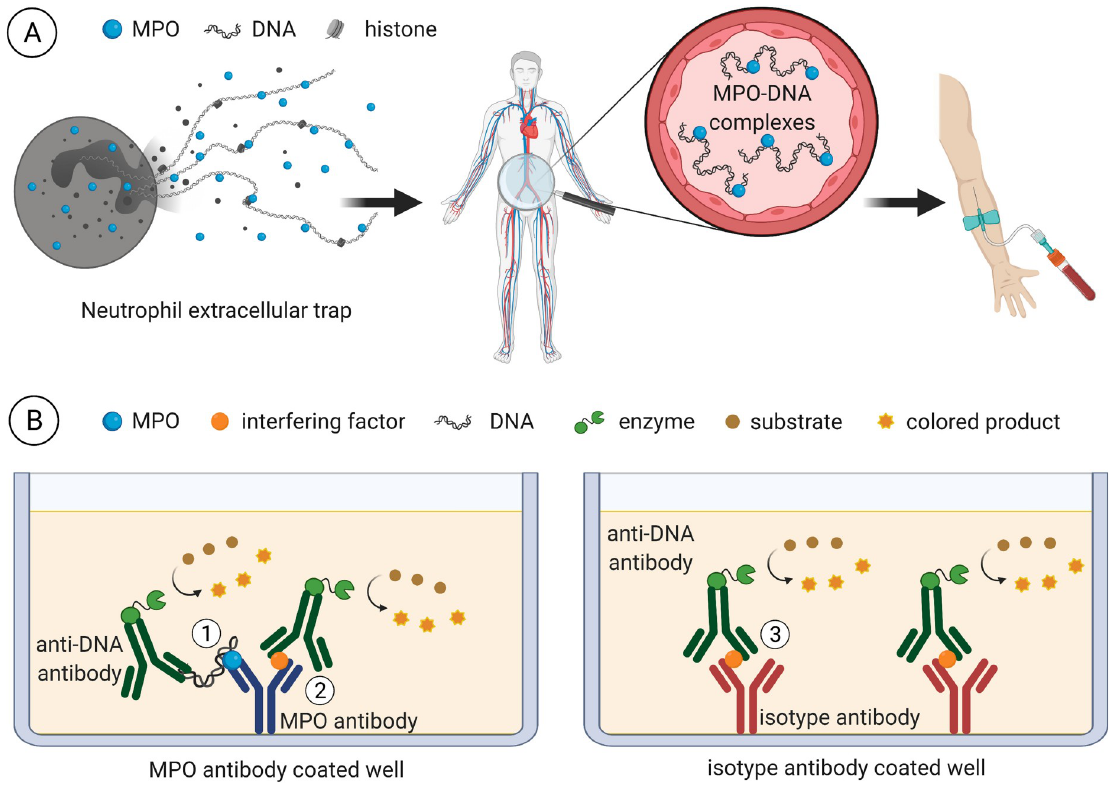
Fig 10. Graphical illustration of MPO-DNA ELISA limitations in human plasma analysis. A) During inflammatory conditions, NETs are formed locally. It is proposed that NET components such as MPO-DNA complexes are released into circulation and can be detected in plasma samples. B) When sandwich ELISAs are performed for MPO-DNA measurements, the capture antibody is commonly directed against MPO. The DNA moiety is then detected with an anti-DNA antibody conjugated to an enzyme for substrate turnover into a colored product (1). In plasma samples, a putative interfering factor (likely a multivalent substance) additionally mediates unspecific interactions between the two antibodies (2). This is revealed, when the capture antibody is exchanged for an isotype control and the interfering factor retains its capacity for immune complex assembly which is independent of the presence of MPO or DNA as documented by our analyses (3). The figure was prepared with BioRender online tool (Toronto, Canada).